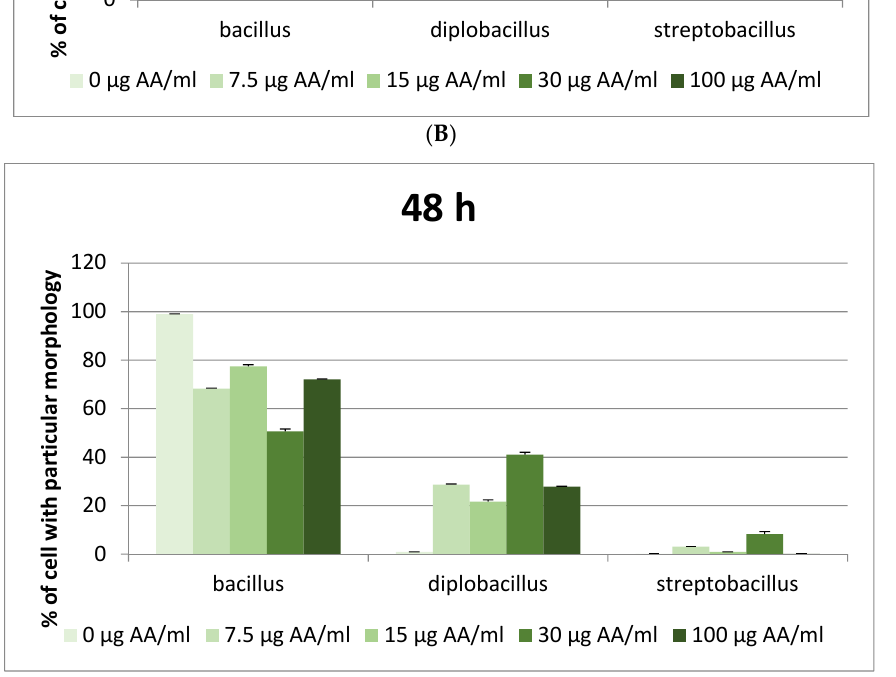
Figure 2. Impact of acrylamide concentration on the morphology of Lactobacillus plantarum . ( A ) 0 h, ( B ) 24 h, ( C ) 48